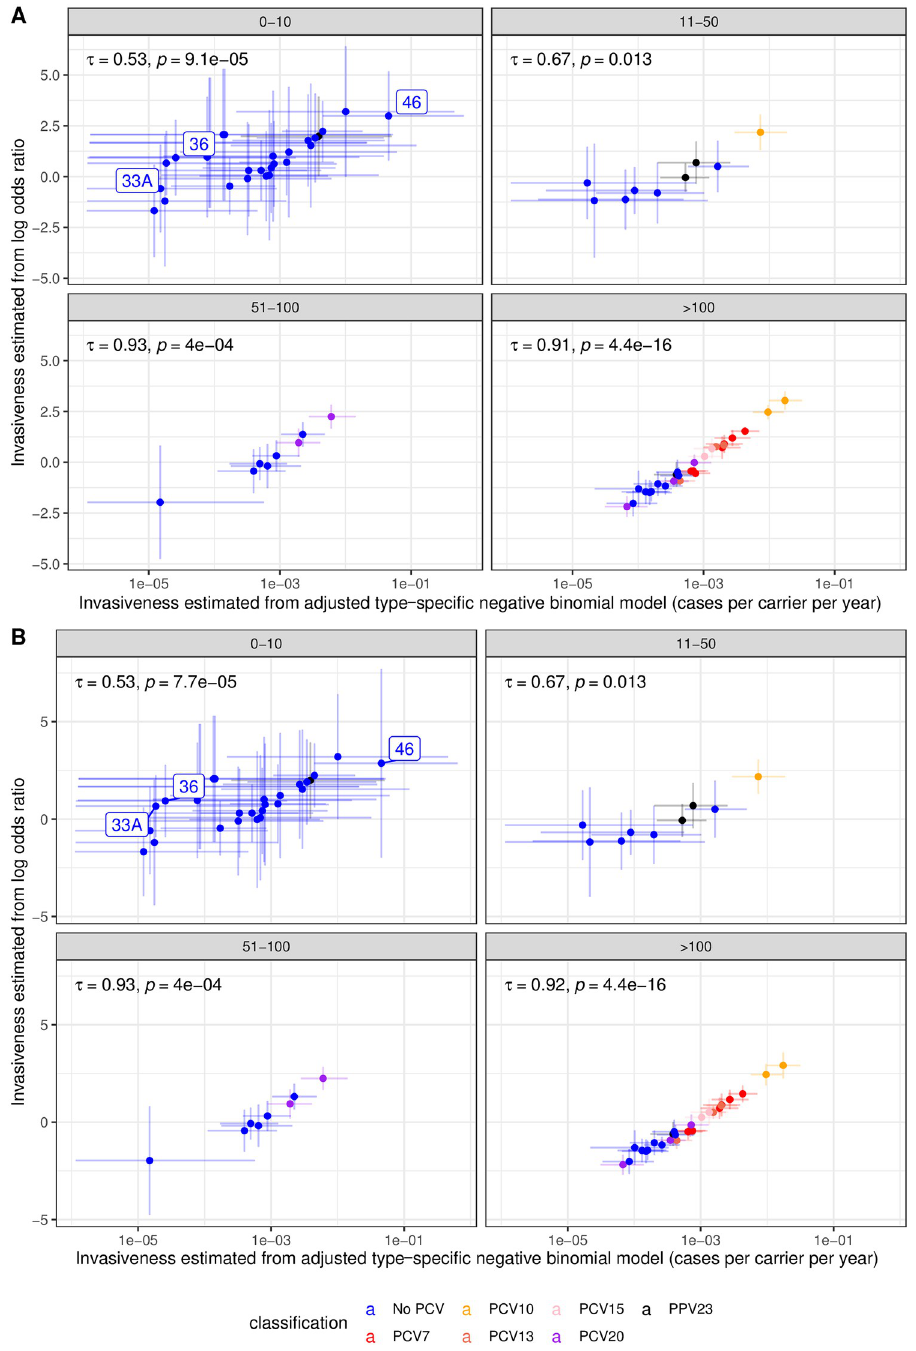
Fig 3. Comparison of the serotype invasiveness estimates from the study-adjusted type-specific negative binomial model with those from meta-analyses of the same dataset calculated as logarithmic odds ratios combined using (A) fixed effects models and (B) random effects models. Points are coloured based on the vaccine formulations in which serotypes are found. The horizontal error bars are the 95% credibility intervals from the Bayesian model, and the vertical error bars show the 95% confidence intervals from the logarithmic odds ratio analyses. Each plot is divided based on the sample size associated with each serotype, calculated as the sum of isolates from carriage and disease across all studies. The correlation between the two estimates is summarised as Kendall’s τ on each panel, with an associated p value.